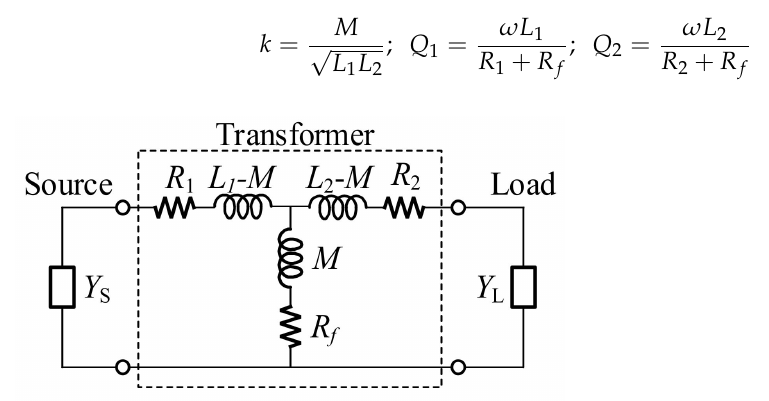
Figure 3. Six-parameter transformer model with general load and